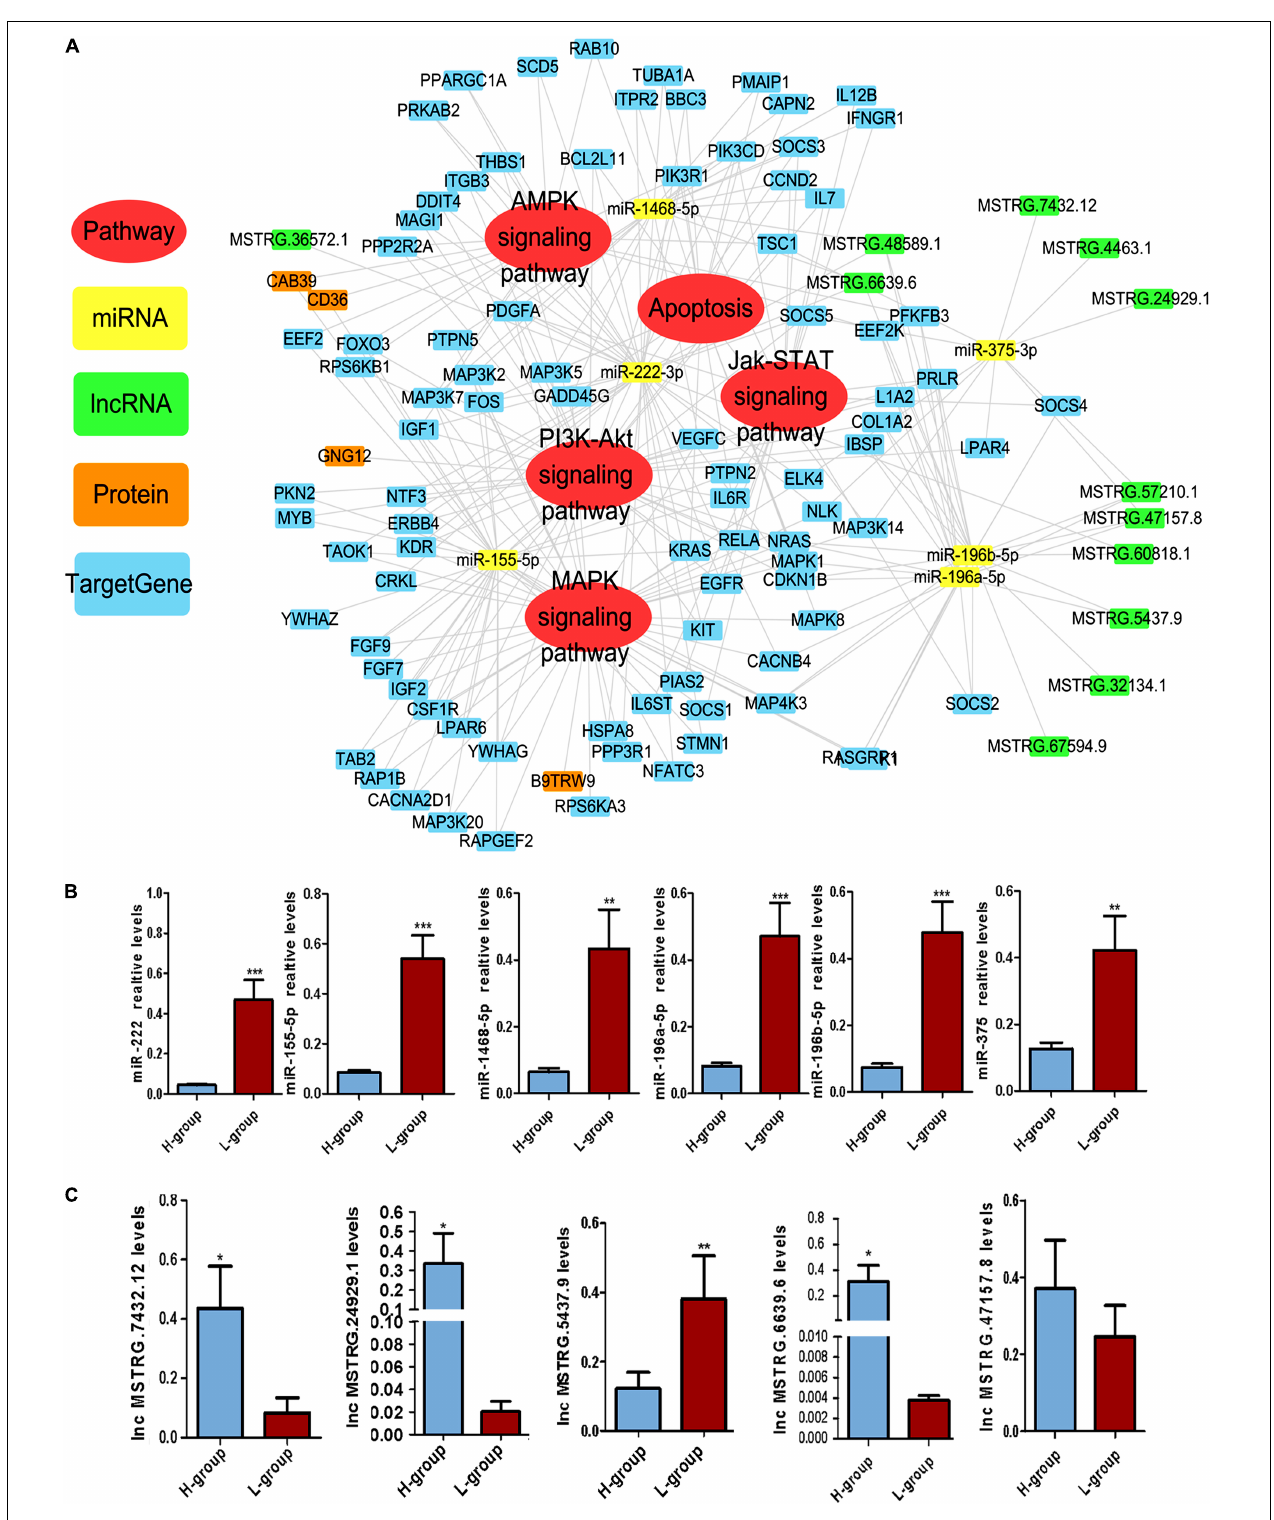
FIGURE 3 | Competing Endogenous RNA (CeRNA) regulatory networks in Duroc boars with different sperm motility. (A) The ceRNA network was based on DEMs, DELs and DEM target genes. The network consisted of five signaling pathways, including the AMPK, apoptosis, Jak-STAT, PI3K-AKT, and MAPK signaling pathways. The DEMs, DELs, DEPs and DEM target genes in the network are presented in different colors. (B) qPCR validation results for DEMs in the ceRNA network. (C) qPCR validation results for DELs in the ceRNA network. * P ≤ 0.05, ** P < 0.01, *** P ≤ 0.001 (Student’s t -test), n = 4 for each group.